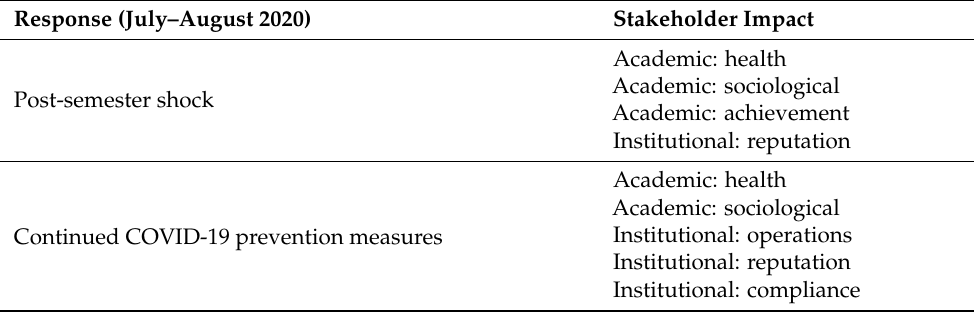
Table 5. Impacts of the COVID-19 response for the summer session of 2020 at Graduate School